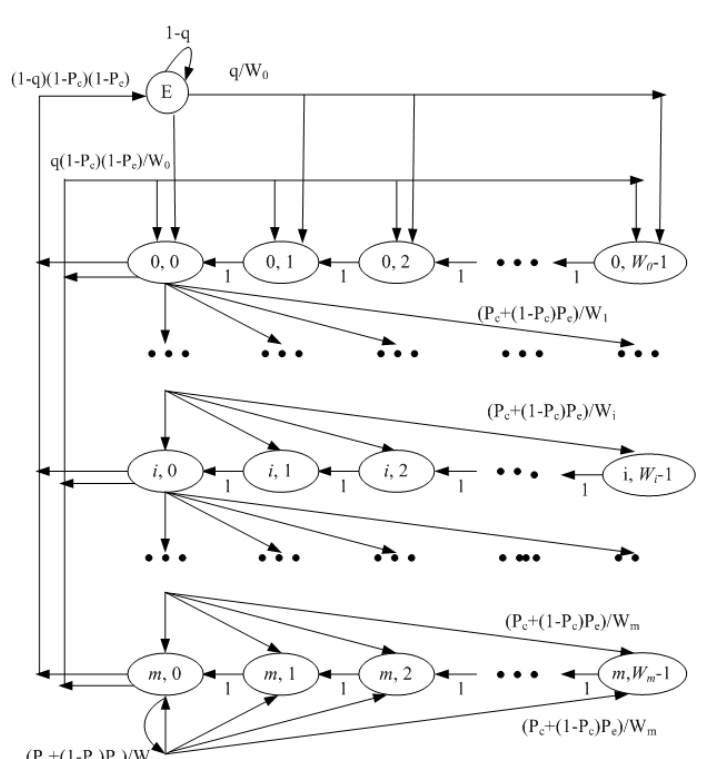
Figure 2. A two dimensional Markov chain model that takes into account capture